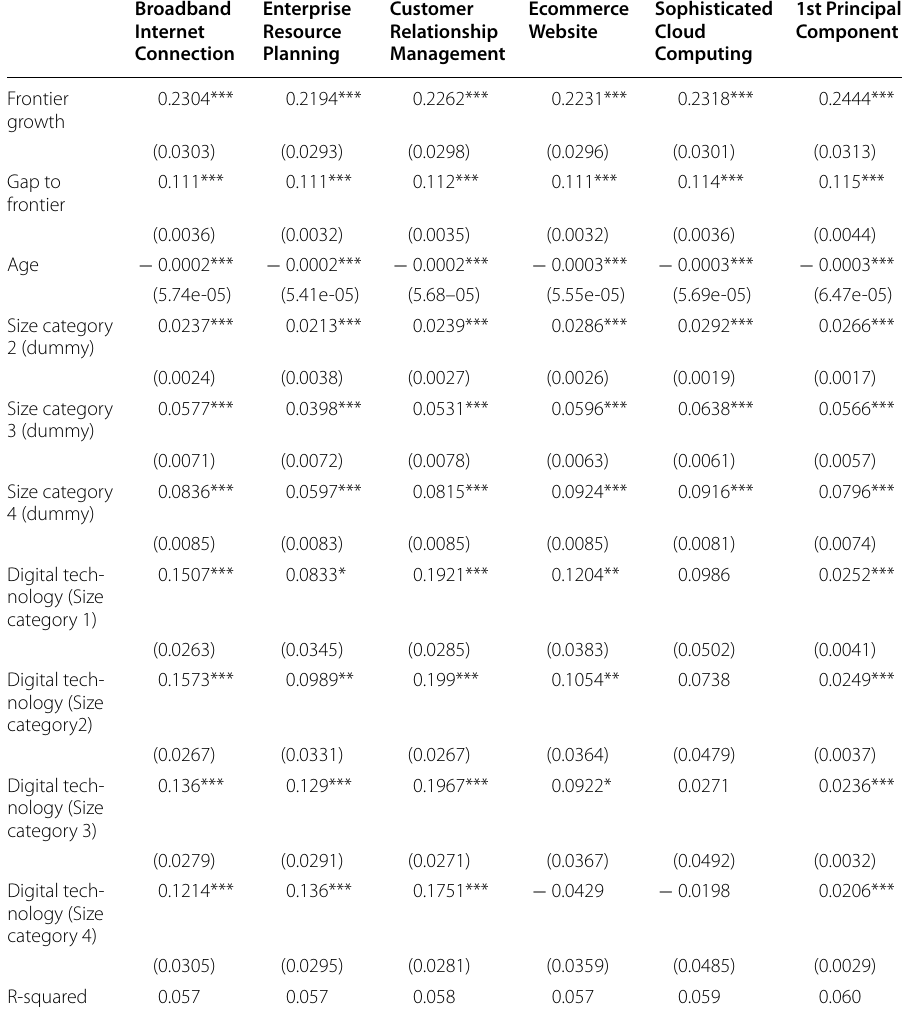
Table 9 Observing the impact of digital adoption on efficiency by size